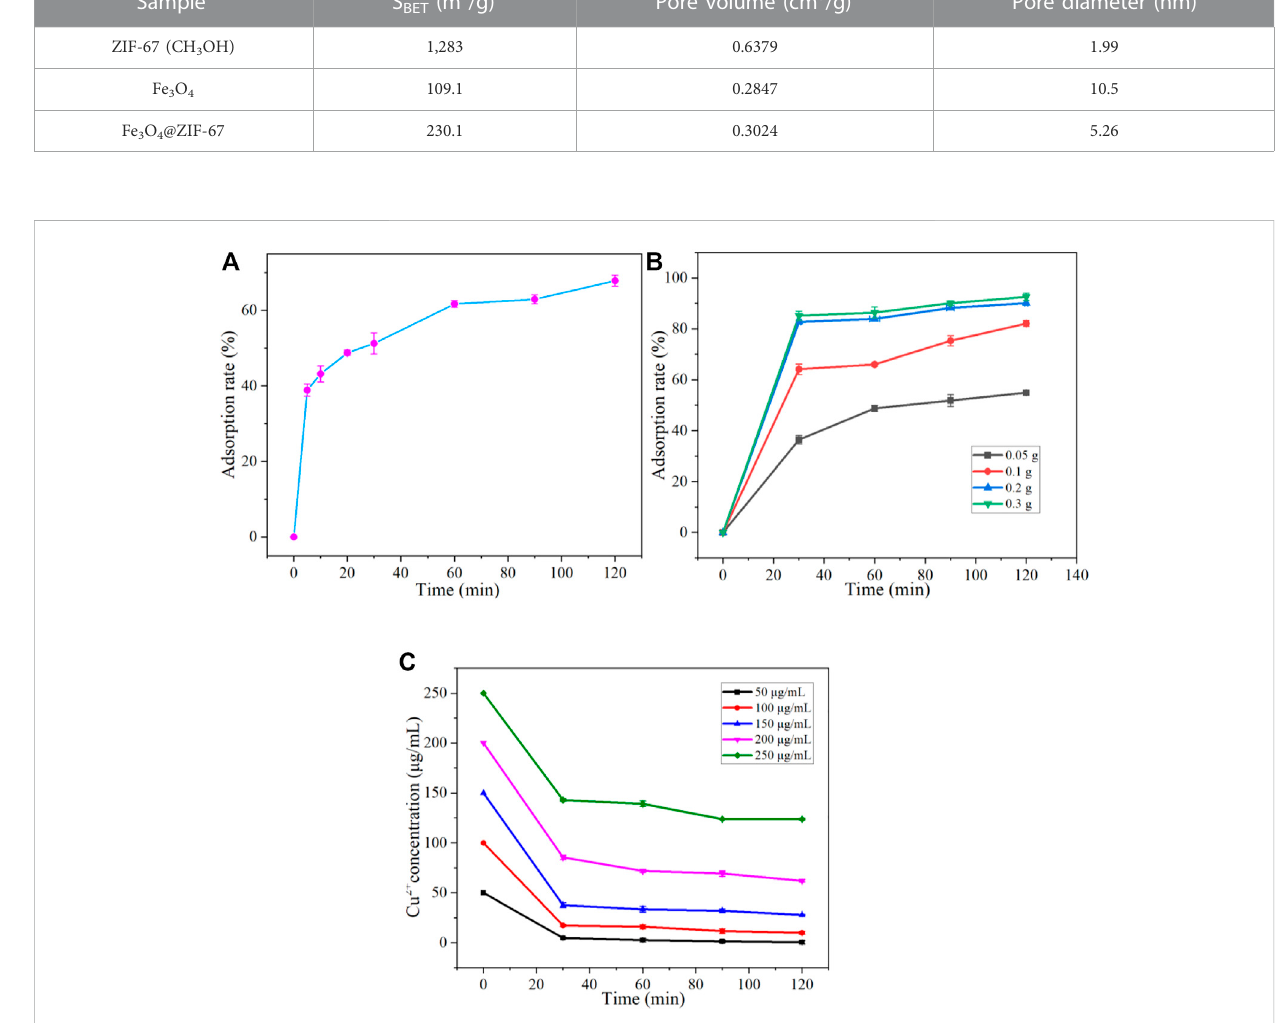
FIGURE 6 Effect of Adsorption time (A) , Adsorption dose (B) , and Initial concentration (C) on adsorption of Cu 2+ by Fe 3 O 4 @ZIF-67.